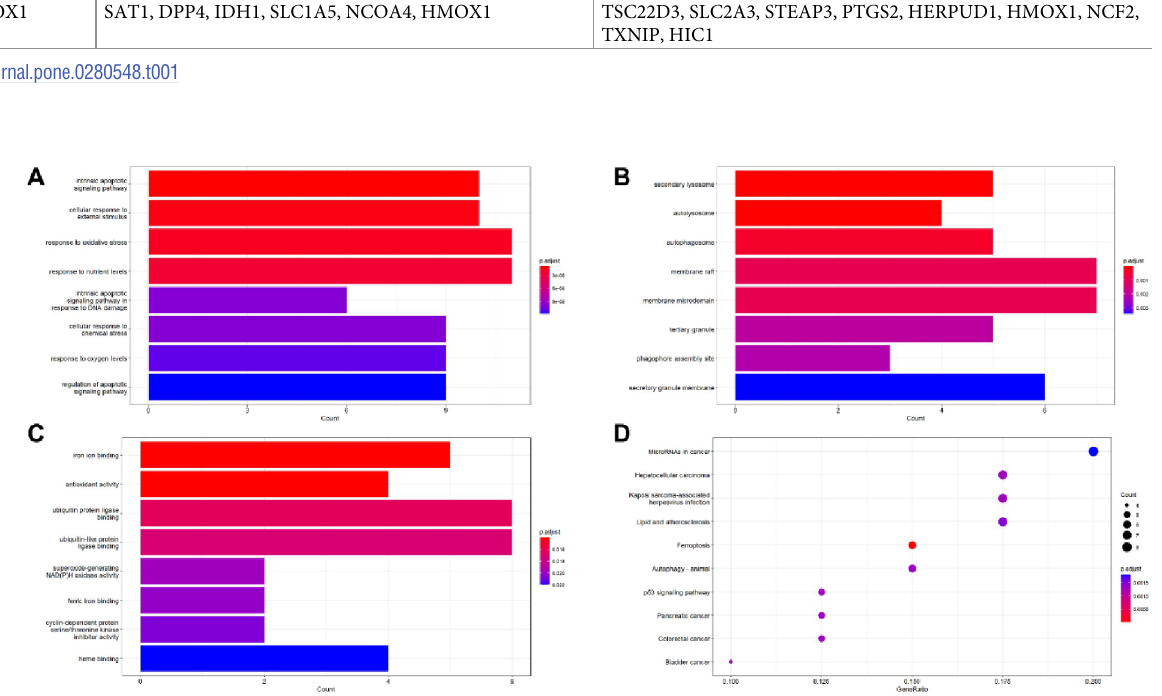
Fig 4. Functional enrichment analysis of DE-FRGs. (A-C) The GO analysis shows BP (Biological process), CC (Cellular component) and MF (Molecular function) respectively. (D) KEGG pathway analysis.